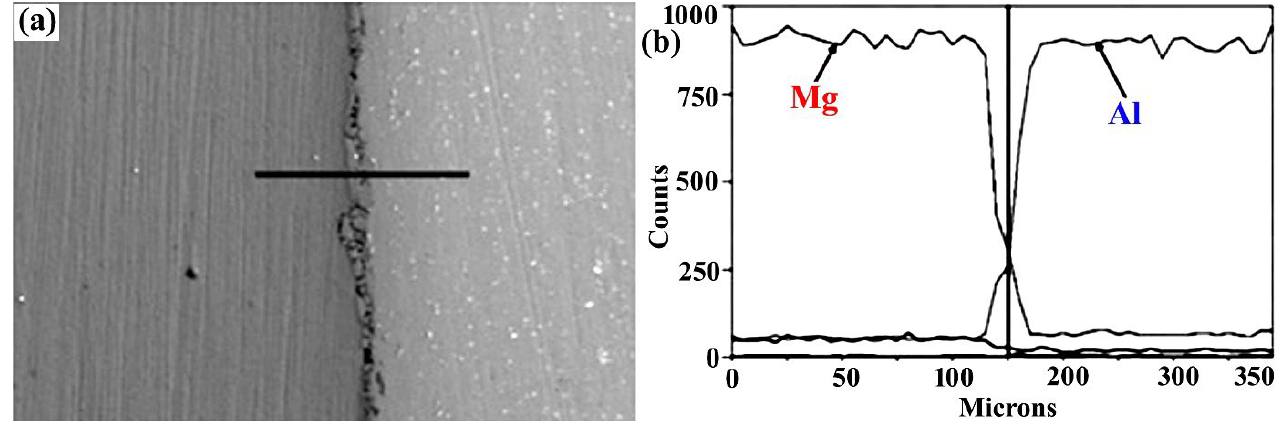
Figure 12. SEM micrograph showing an interlayer present between the Mg/Al dissimilar R-FSSW weld, and ( a ) EDX line scan across the interlayer indicated in ( b ), ( b ) showing the Mg and Al compositional variations.